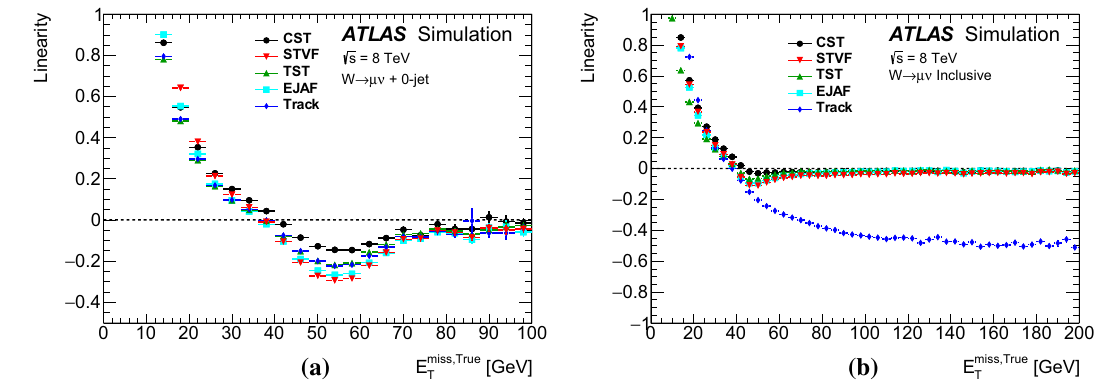
Fig. 11 E miss linearity in W → μν MC simulation is shown versus E miss , True T